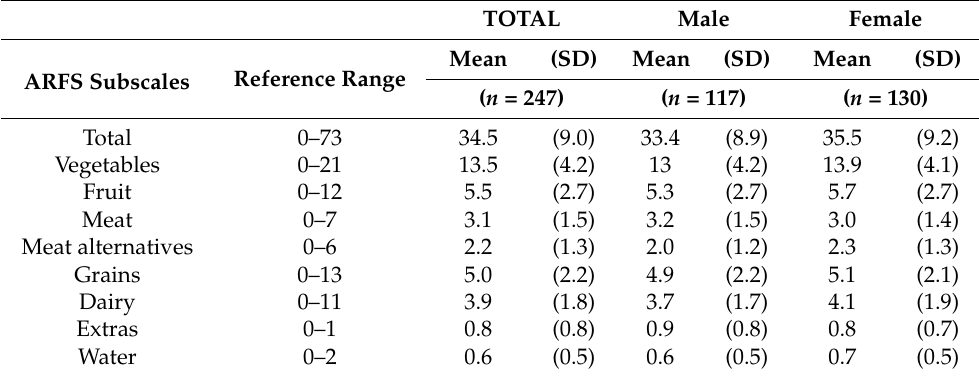
Table 3. Total Australian Recommended Food Score (ARFS), subscales, reference ranges, mean and standard deviation for a sample Australian adults categorised by gender.